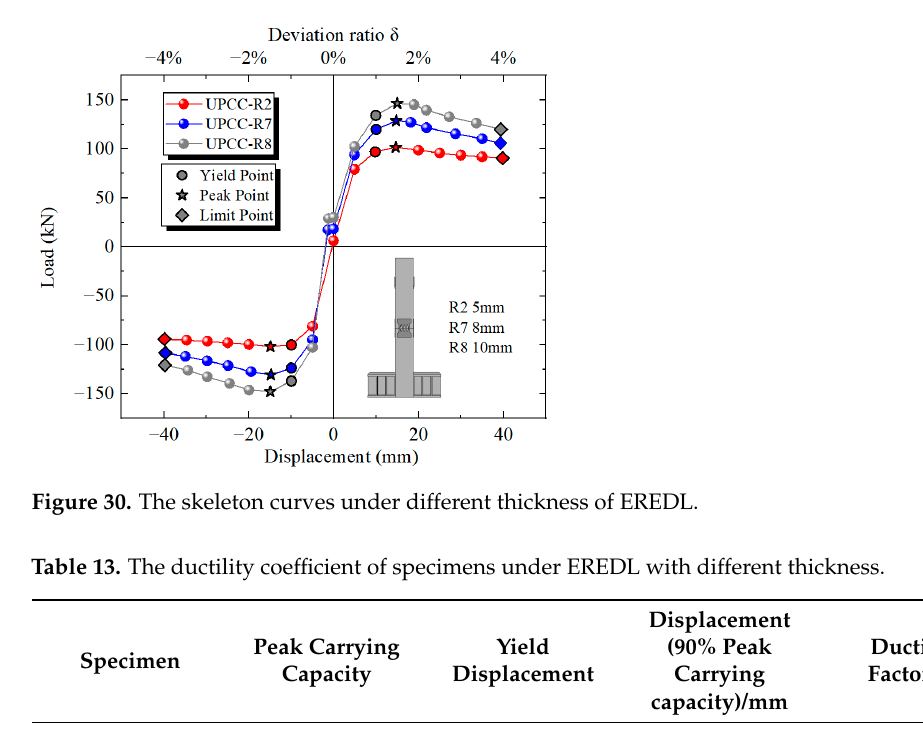
Figure 29. Hysteretic curves under different thicknesses of EREDL.